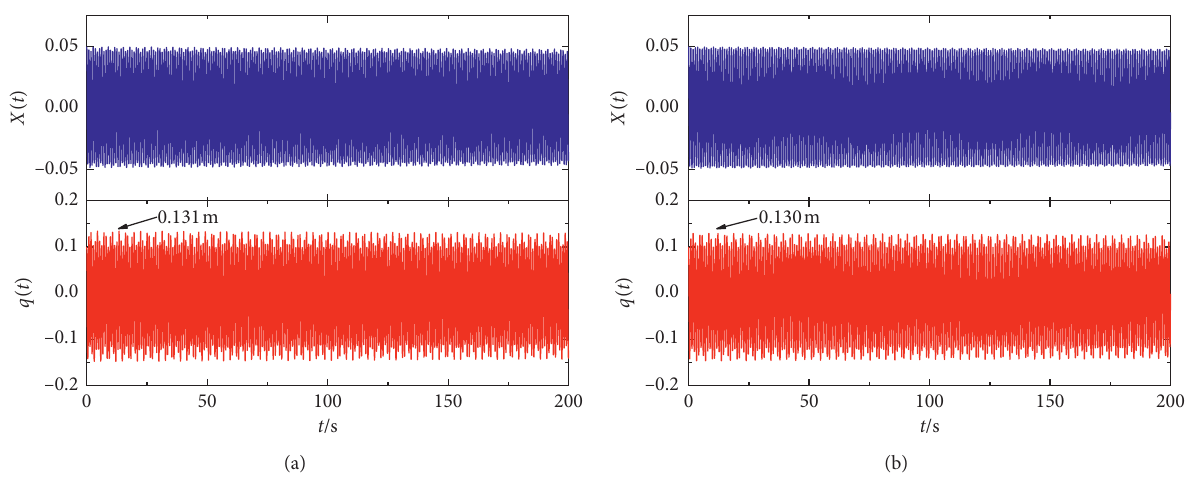
Figure 5: Displacement response (without 1 :1 response mode): (a) the first calculation method of dynamic tension; (b) the second calculation method of dynamic